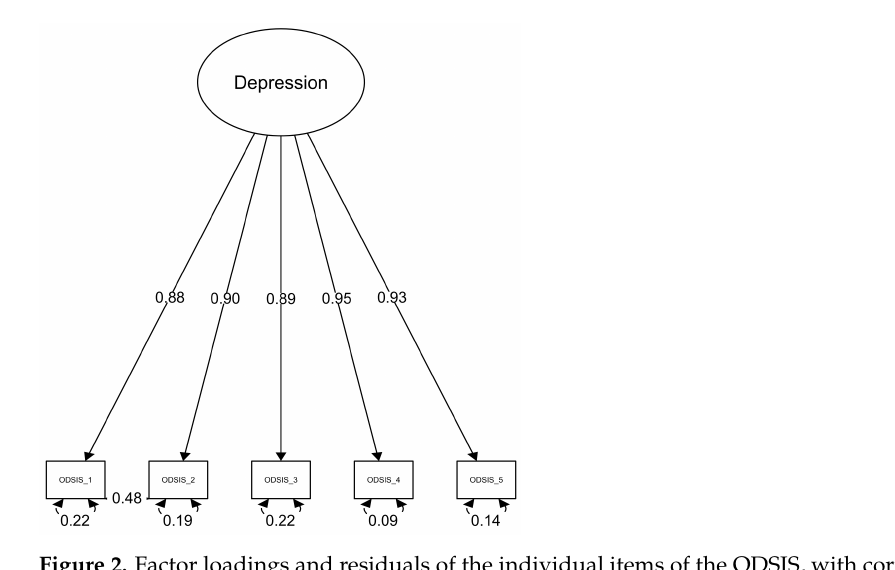
Figure 2. Factor loadings and residuals of the individual items of the ODSIS, with correlated error terms between items 1 and 2 (Sample 2, n =